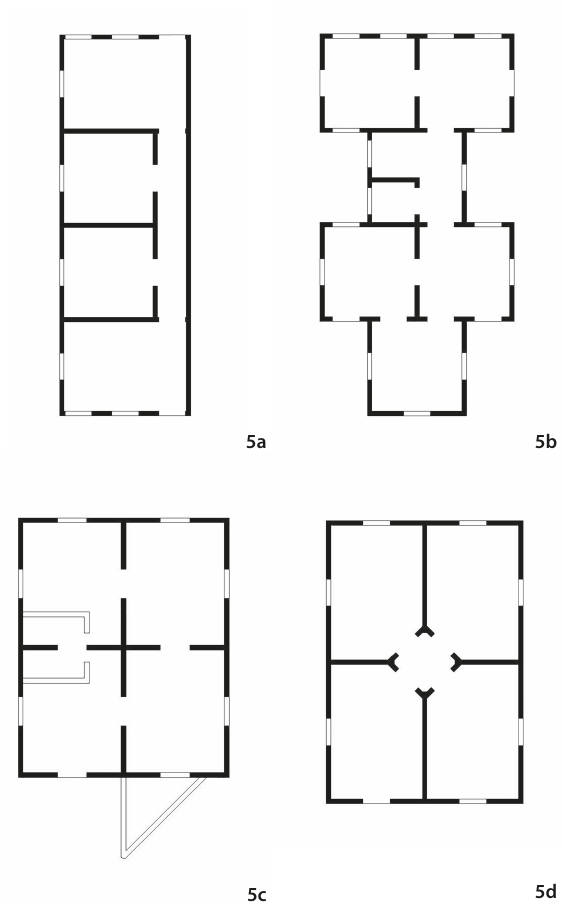
Figure 5 (a) Type 1; (b) Type 2; (c) Type 3; (d) Type 4 (Source: Instituto Pedra,